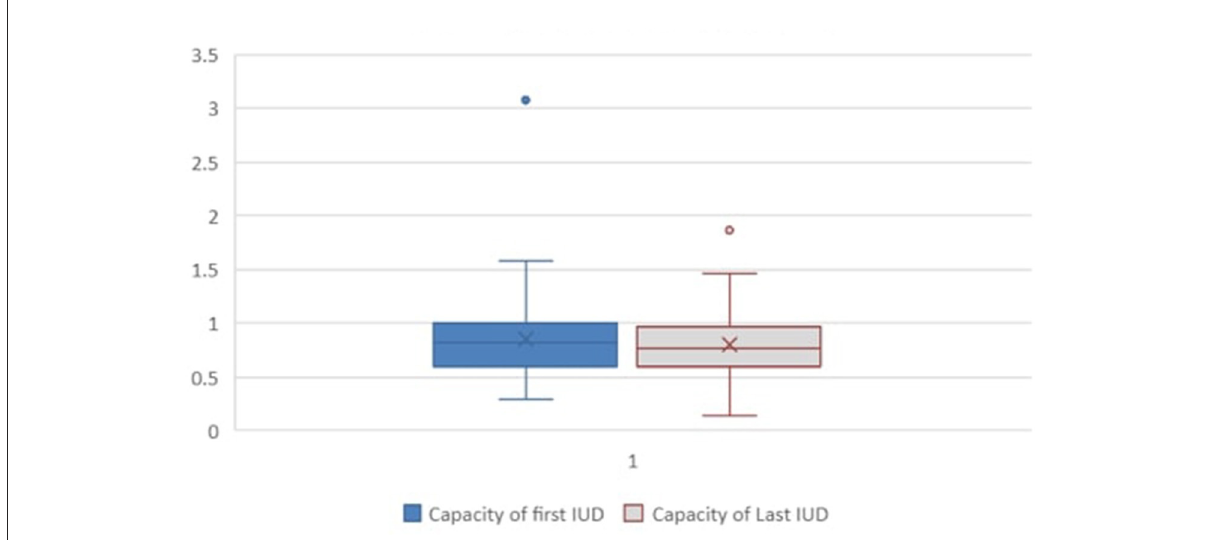
FIGURE1 Bladder capacity – observed/expected (O/E) ratio (mL/mL) at first and last recorded IUDs. Fifty-four patients who had more than one test available were included. Statistical significance was assessed using paired t -test, and a p -value < 0.05 was considered significant. IUD, invasive video urodynamics.